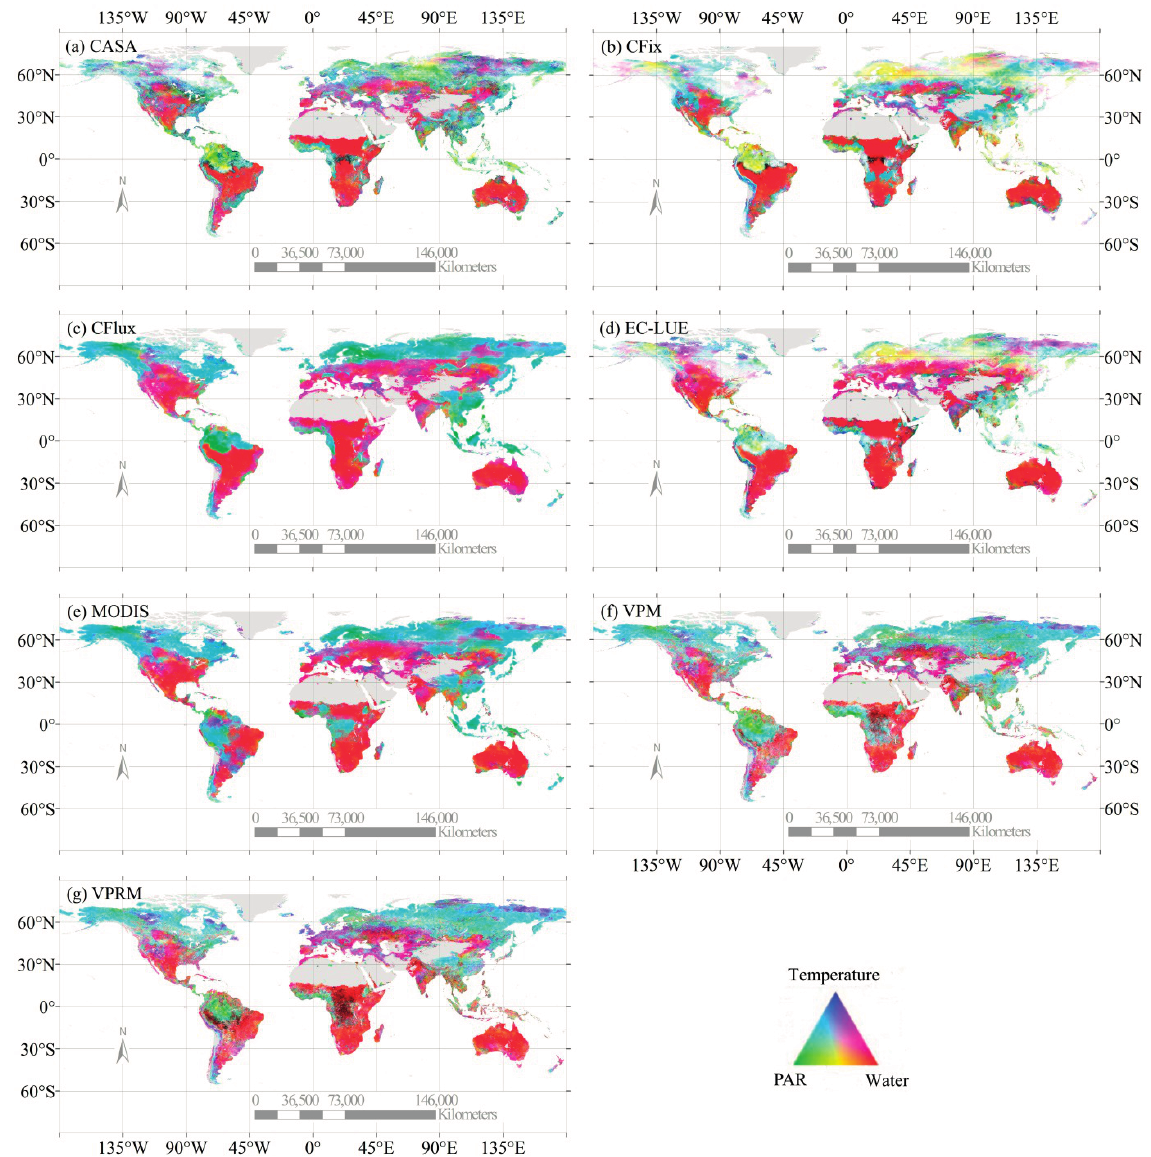
Figure 5. Spatial distribution of the environmental constraints to the annual GPP estimates over the period 2000–2010 of seven LUE models: ( a ) CASA; ( b ) CFix; ( c ) CFlux; ( d ) EC-LUE; ( e ) MODIS; ( f ) VPM; and ( g ) VPRM. Three environmental variables were considered: solar radiation (PAR, Green), air temperature (Blue), and water availability